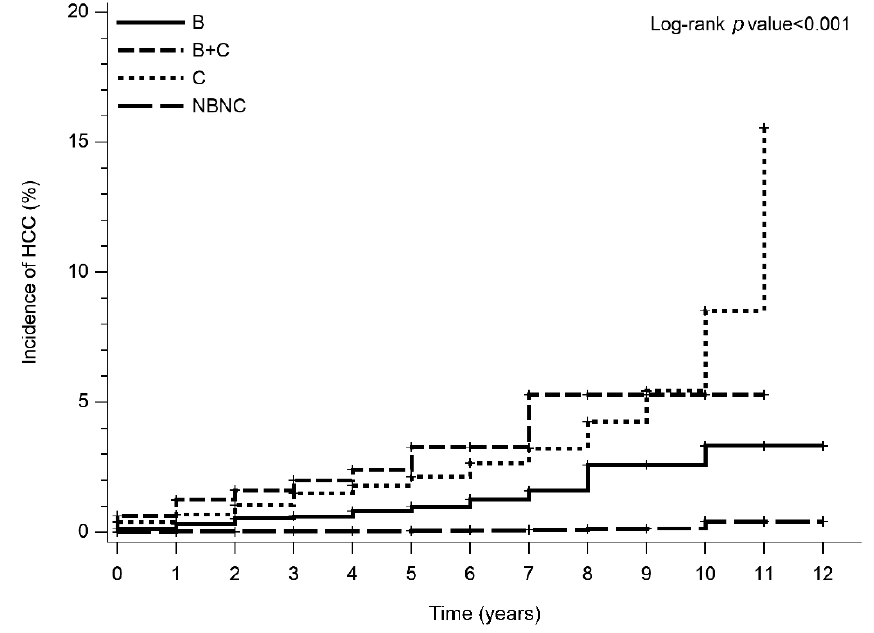
Figure 2. Cumulative incidence of HCC stratified by etiology.